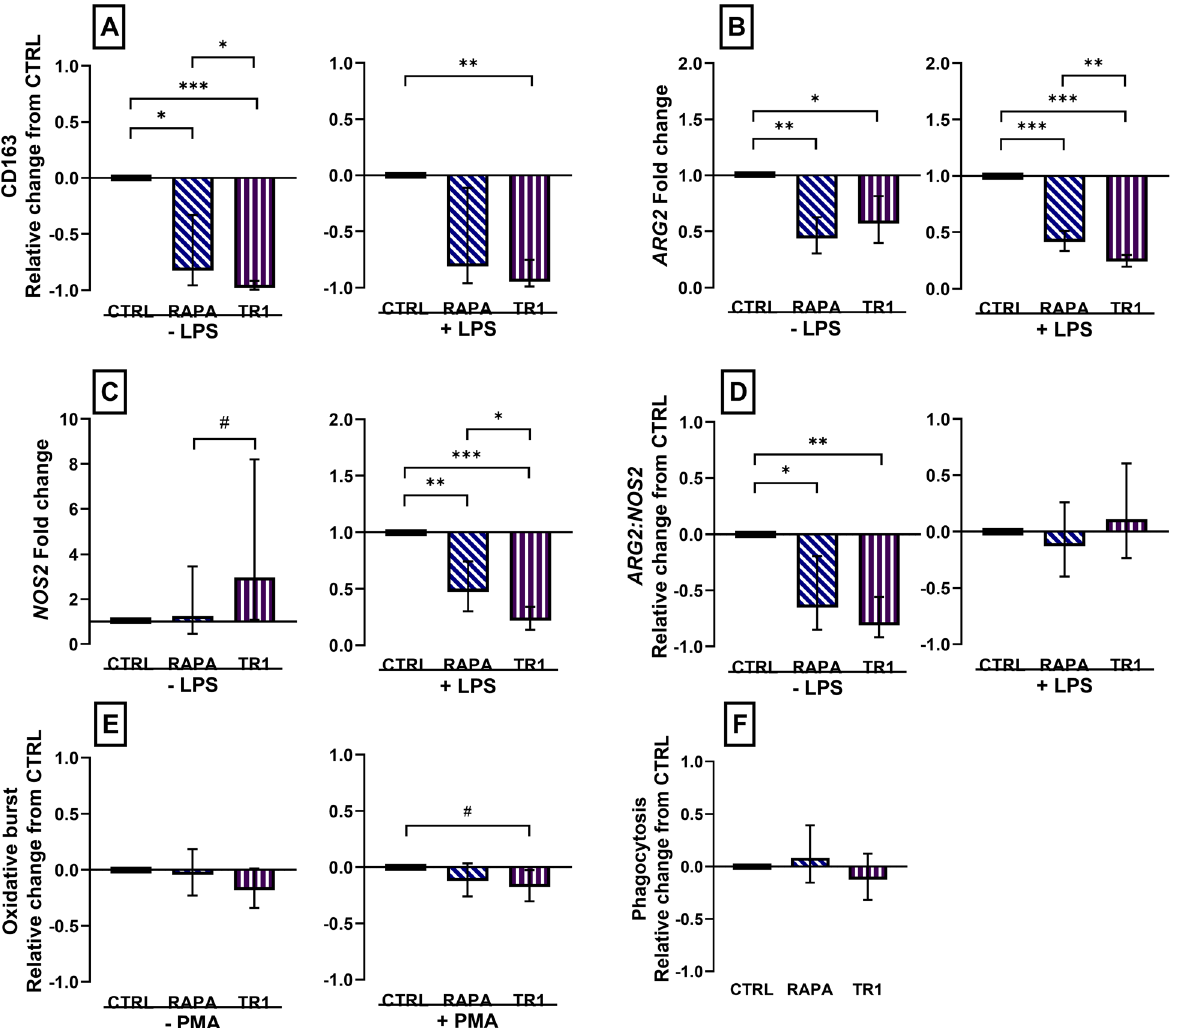
Figure 3. Changes in surface maker expression, mRNA abundance, oxidative burst, and phagocytosis in M2 macrophages polarized for 3 days with 20 ng/mL IL4 and 20 ng/mL CSF1 and concurrently treated with vehicle (CTRL), or inhibitors rapamycin (RAPA) or Torin-1 (TR1) at 100 nM. Cells were incubated with vehicle (− LPS) or stimulated with 100 nM LPS (+ LPS) for 16 h to measure change in CD163 expression ( A ), or 4 h to measure changes in mRNA abundance of arginase 2 ( ARG2, B ) and inducible nitric oxide synthase ( NOS2, C ) and their ratio ( D ). Cells were incubated with 10 µM H 2 DCFDA fluorescein loading dye for 15 min and stimulated with phorbol myristate acetate (PMA) at 0 (− PMA), or 25 (+ PMA) ng/mL for 15 min to measure oxidative burst ( E ), or for 1 h with pHrodo bioparticles to measure cellular phagocytosis ( F ). Data were expressed relative to CTRL and presented as the relative change from CTRL in unstimulated and stimulated cells for CD163, ARG2:NOS2 , phagocytosis, and oxidative burst. mRNA abundance was expressed as the fold change from CTRL in unstimulated and stimulated cells. Data from cell isolation of 12 cows are presented as the geometric mean and backtransformed 95% confidence interval. ANOVA tests between CTRL and inhibitors, and between inhibitors are presented with Bonferroni-adjustment for multiple comparisons: P ≤ 0.10 ( # ), P ≤ 0.05 (*), P ≤ 0.01 (**), P ≤ 0.0001